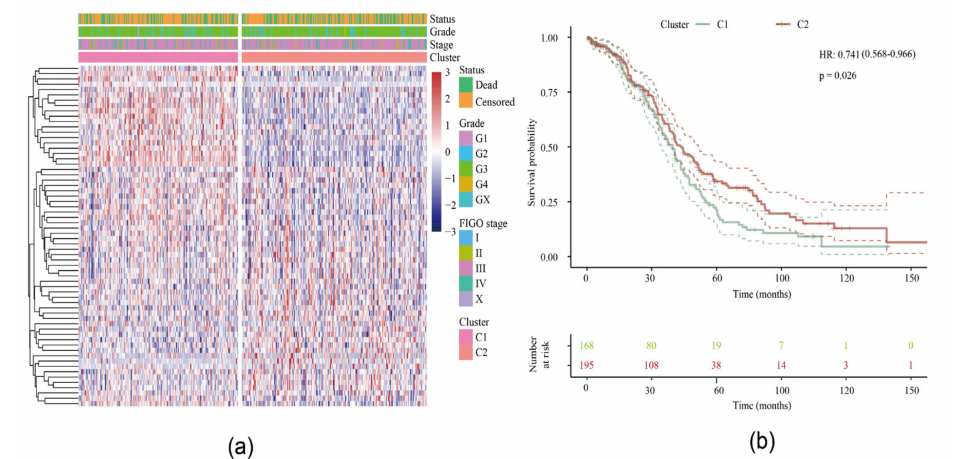
Figure 1. Identification of two molecular subtypes: ( a ) Heat map of clustering of 64 prognosis-related genes. ( b ) Survival curve of molecular subtypes including hazard ratio (HR) with 95% confidence interval (CI) and p -value. Int. J. Mol. Sci. 2020 , 21 , x FOR PEER REVIEW